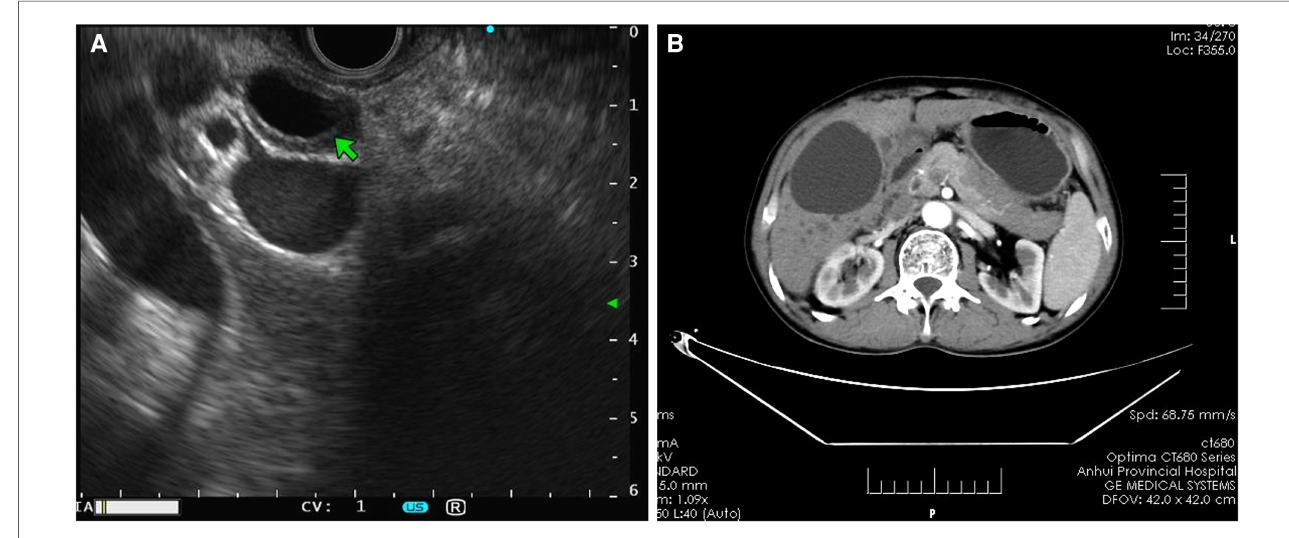
FIGURE 2 Imaging features of AIP. ( A ) Endoscopic ultrasound revealed bile duct wall thickening and common bile duct dilatation with the bilateral sign in patients with AIP. ( B ) Computed tomography scan showed an even thickening of the common bile duct wall, evident enhancement in the arterial phase, and uneven and irregular enhancement of the head and neck areas. AIP, autoimmune pancreatitis.